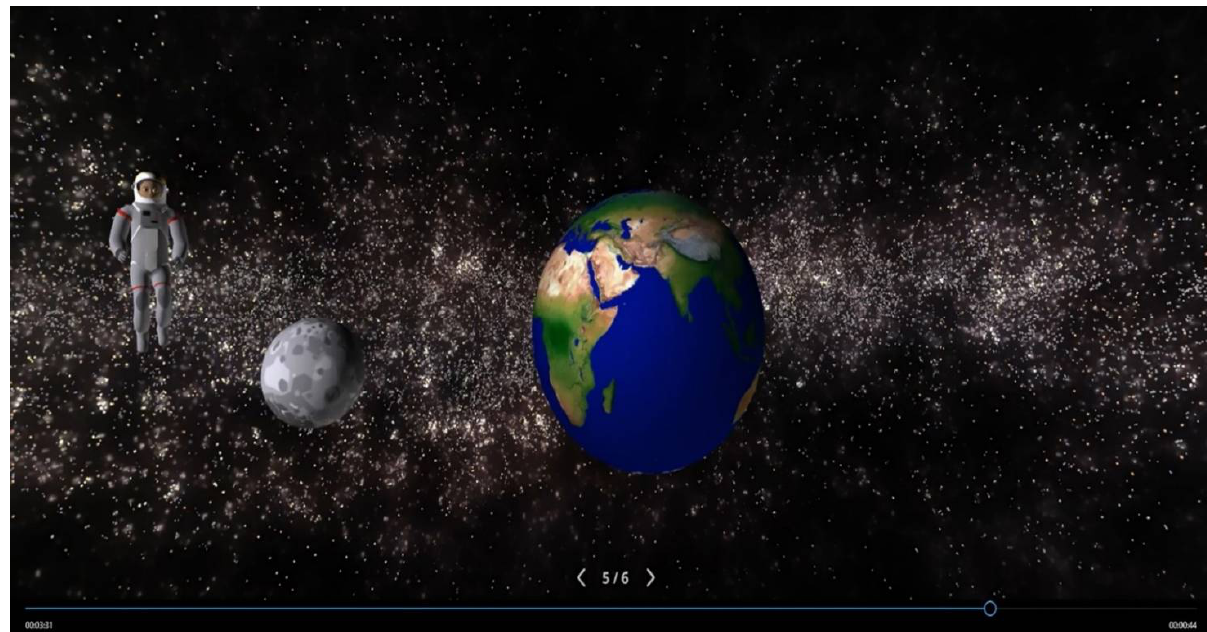
Figure 1. Example # 1 of students ’ virtual environments (outer space) .